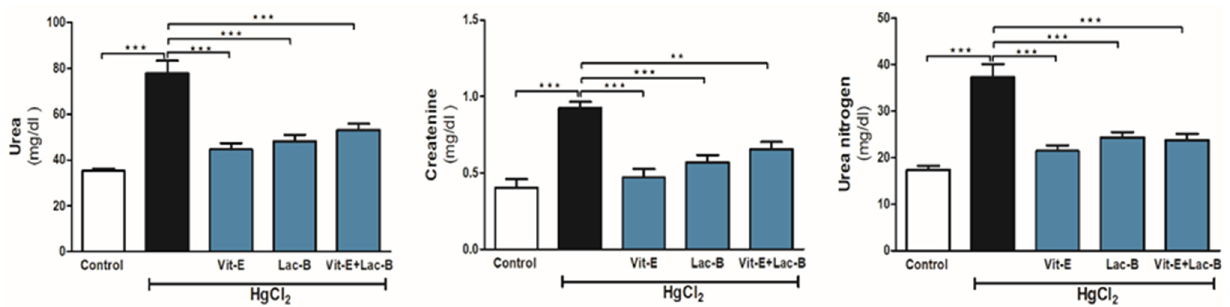
Figure 1. Vit-E and Lac-B prevented HgCl 2 -induced renal injury in rats. Treatments with Vit-E and Lac-B either alone or in combination ameliorated serum urea, urea nitrogen and creatinine levels. Data are expressed as mean ± SEM, ( n = 6). ** p < 0.01 and *** p < 0.001.